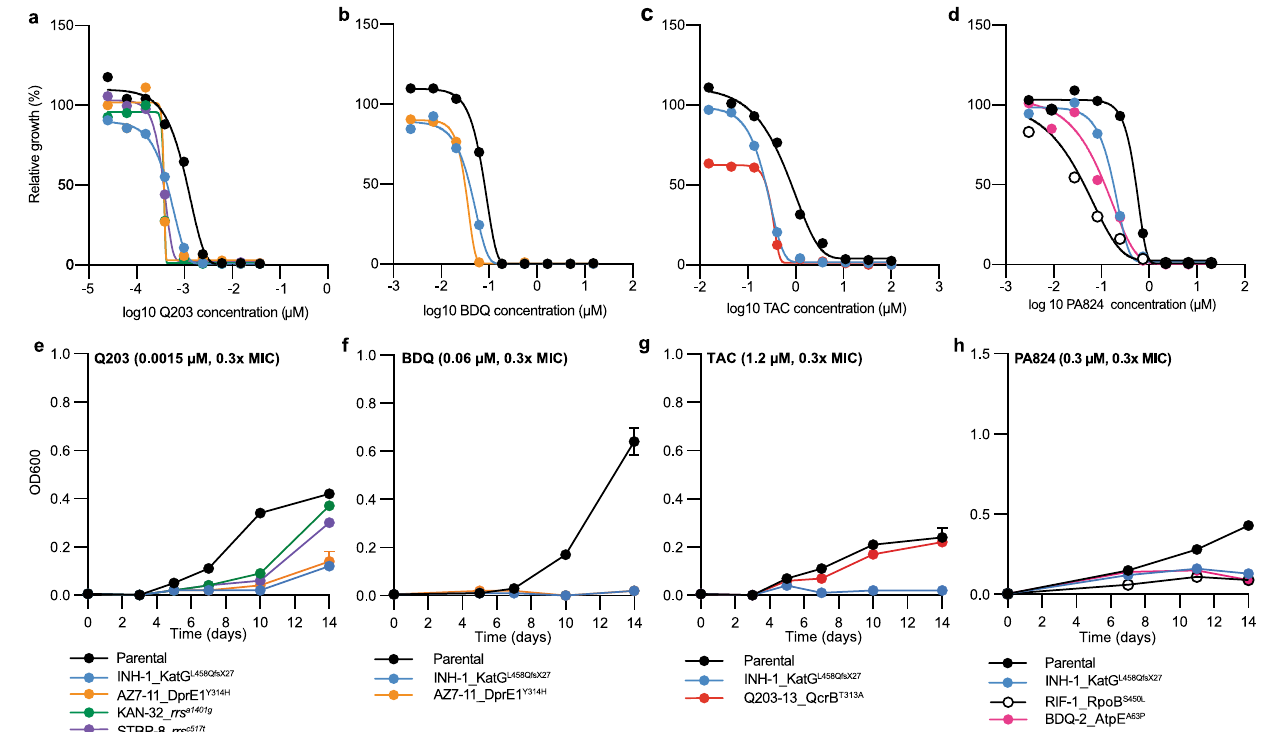
Fig.3|Collateraldrugsensitivitiescanbetargetedtolimitthegrowthofdrug- resistant variants of M. tuberculosis . a – d Dose – response curves for selected drug-resistantvariantsandthedrug-susceptibleparentagainstselectedantibiotics. Strain names and candidate mutations are listed below each dose-response. Dose- responsecurvesaretheresultsofasinglebiologicalreplicatefromarepresentative experiment ( n >4 independent experiments).The Gompertz model was usedto fi t